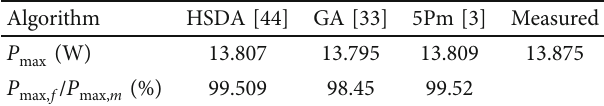
Table 9: The P max forecasted and